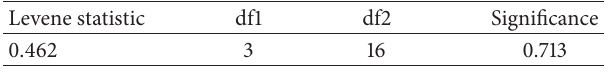
Table 4: Results for Levene test for homogeneity of variance.